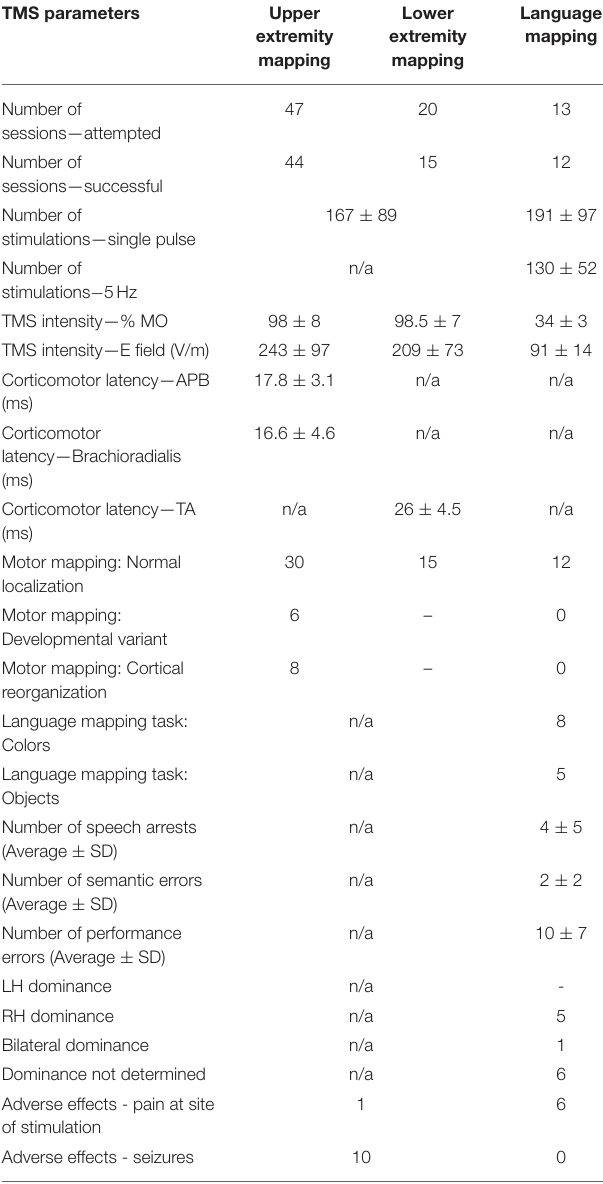
TABLE 2 | TMS parameters in the motor and language mapping